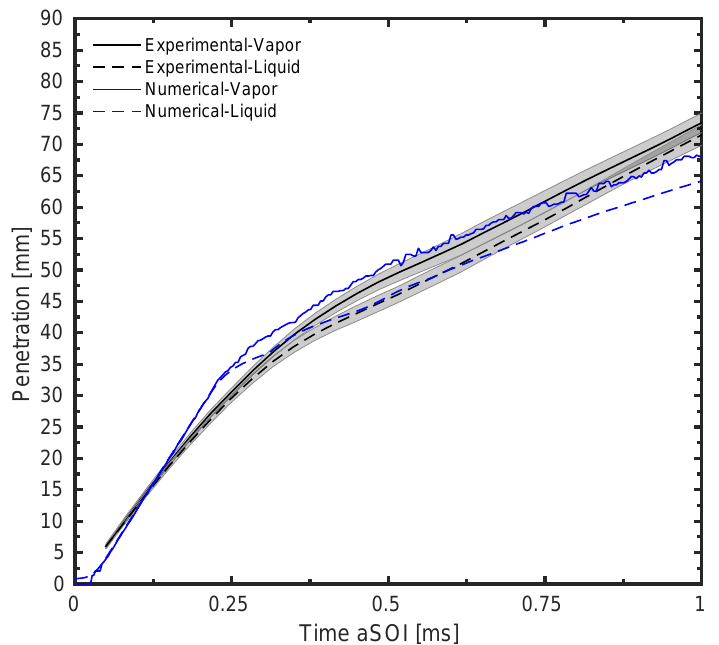
Figure 16. Numerical and experimental axial vapor and liquid phases penetration for the G2 cold condition for